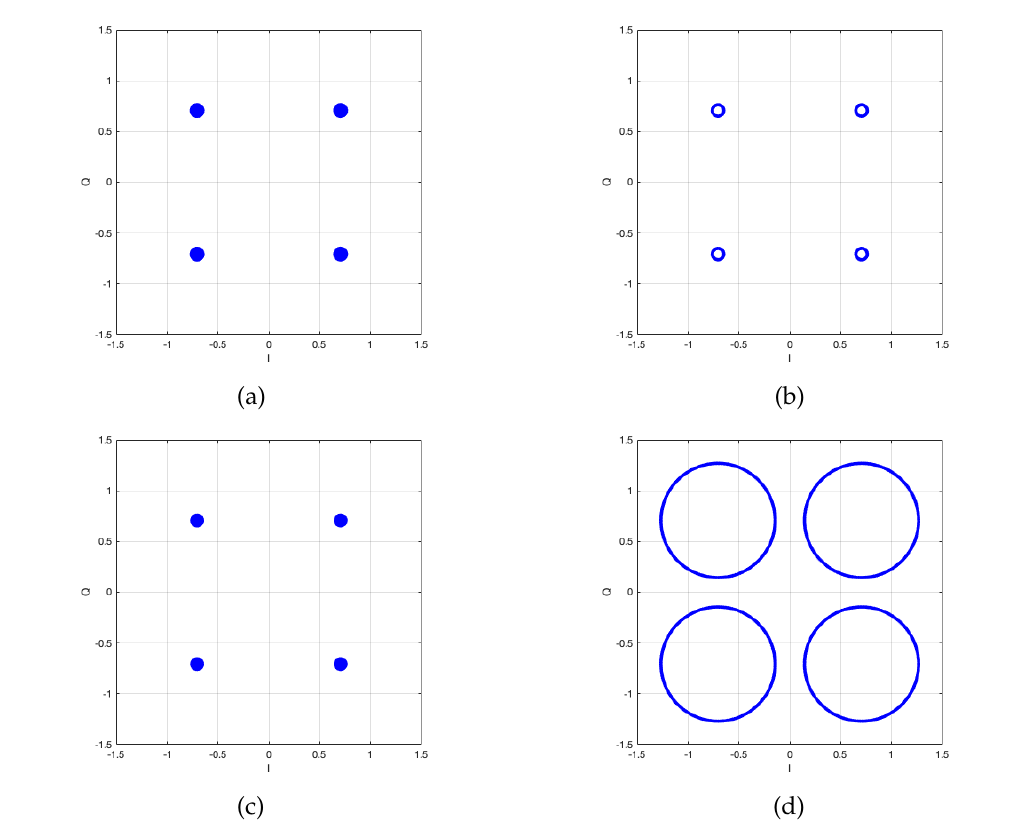
Figure 8. Quadrature phase shift keying (QPSK) constellation with and without interference cancellation depending on the interference power: ( a ) With interference cancellation in –25 dB lower interference than the desired signal, ( b ) without interference cancellation in –25 dB lower interference than the desired signal, ( c ) with interference cancellation in –5 dB lower interference than the desired signal, and ( d ) without interference cancellation in –5 dB lower interference than the desired signal.